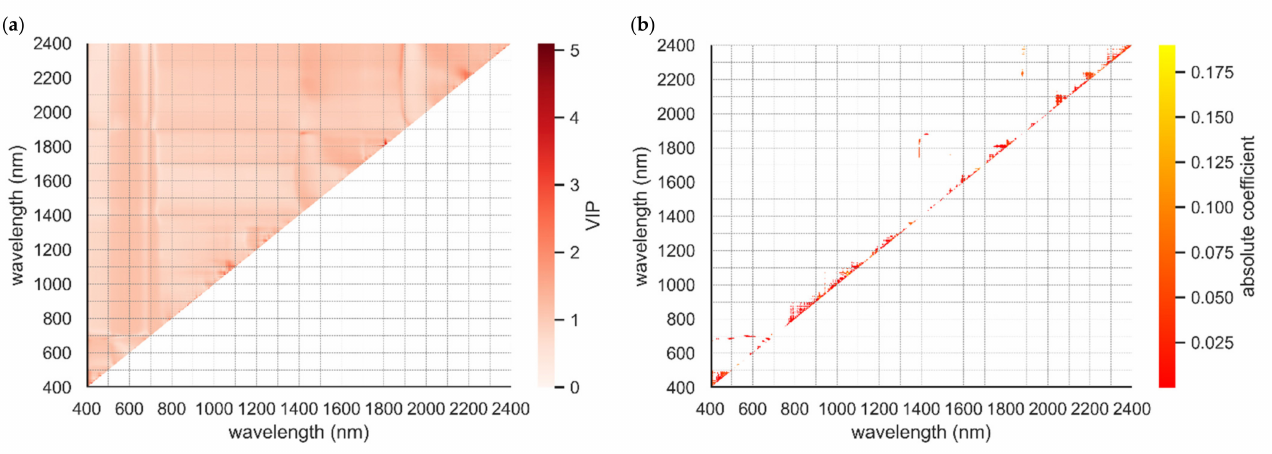
Figure 12. Variable importance for simple ratio indices computed by PLSR ( a ) and SVR based on RFECV-selected variables ( b